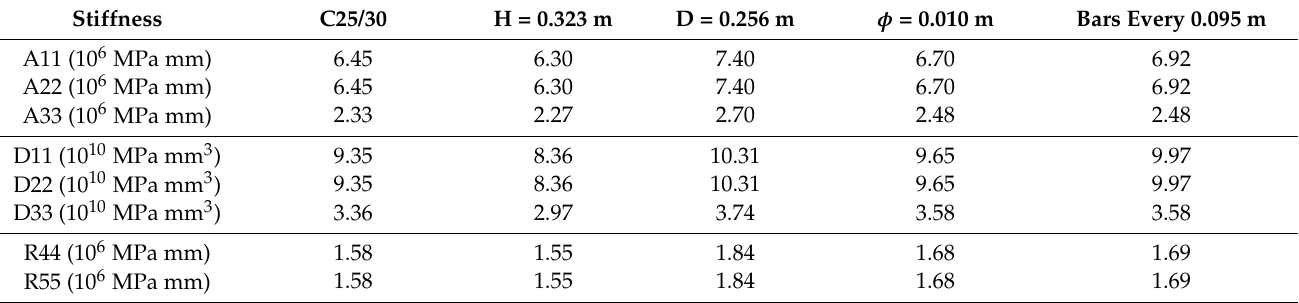
Table 5. Stiffness for RVE BD340 in case of reducing the value of individual cross-section parameters. Stiffness